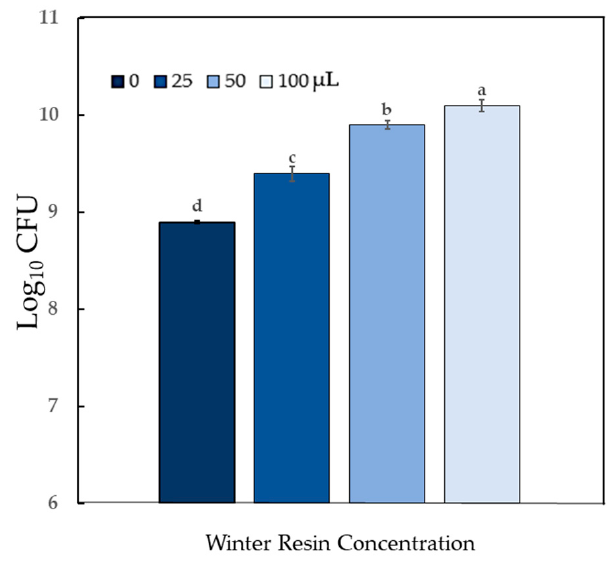
Figure 4. Growth stimulation of Pseudomonas syringae pv. tomato with autoclaved Sv resin. Resin was collected in winter and evaluated within 72 h. Treatment doses (0, 25, 50, and 100) are volumes of suspended resin ( μ L) in a total volume of 300 μ L. Bars with the same letter are not different according to Tukey’s test at P < 0.0001. Data shown are arithmetic means + standard errors.